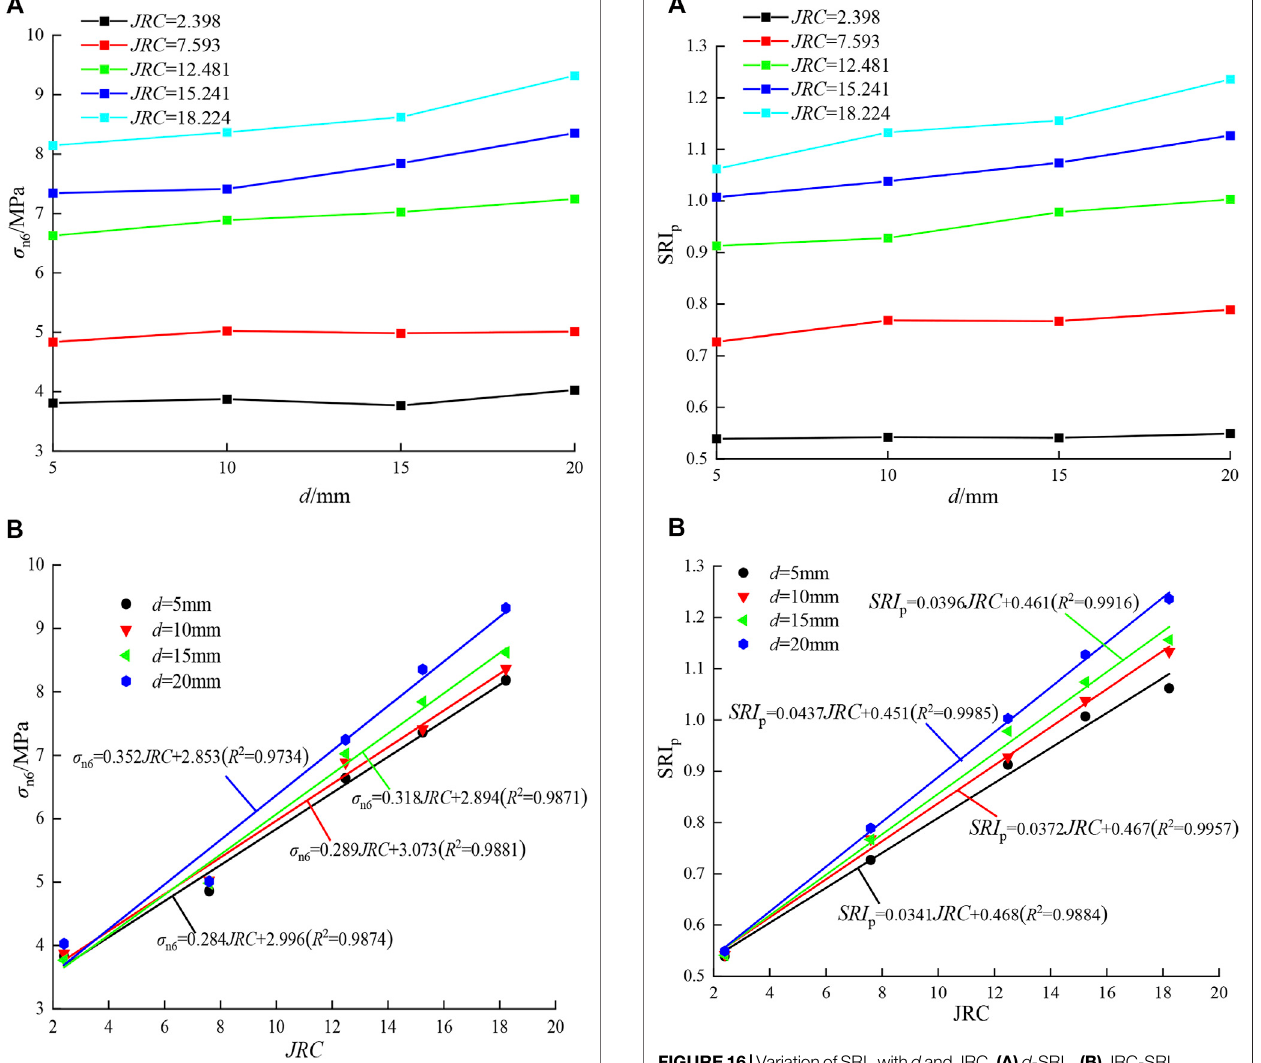
Frontiers in Earth Science |